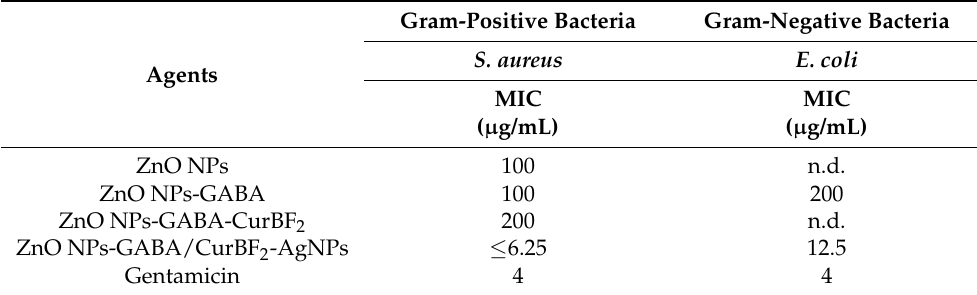
Table 3. Minimum inhibitory concentration (MIC) of each agent against Gram-positive and Gram- negative bacteria.